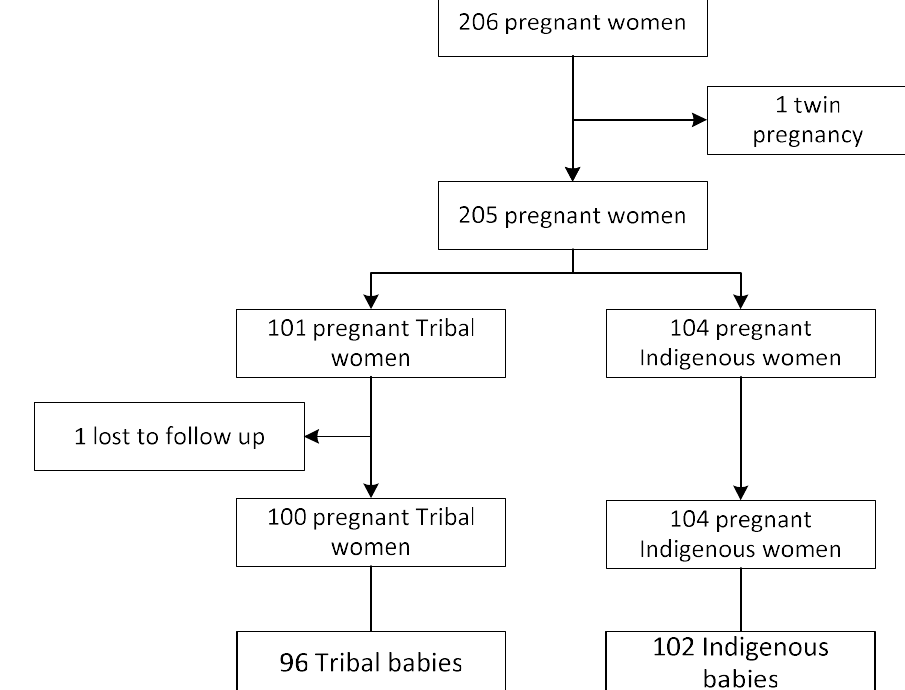
Figure 1. Enrolment flowchart.